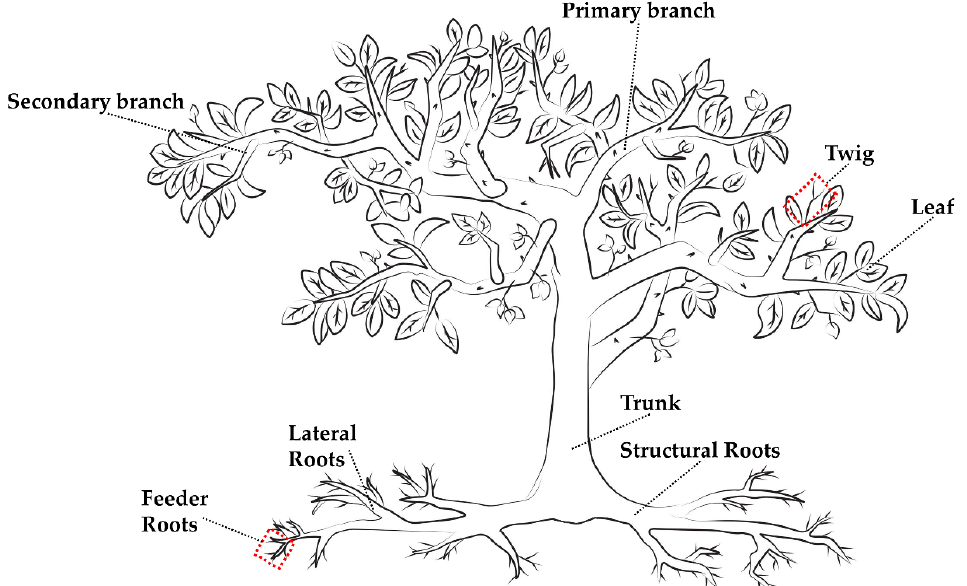
Figure 7. Schematic representation of a six-year-old grapefruit tree divided into eight different components: leaf, twig, secondary branch, primary branch, trunk, structural root, lateral root, and feeder root .